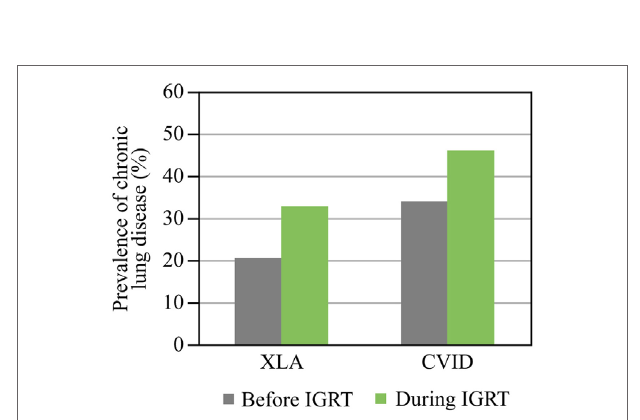
FigURe 3 | Prevalence of chronic lung disease before and during immunoglobulin replacement therapy (IGRT). Prevalence before and during IGRT is shown. Data for chronic lung disease are from Plebani et al. (XLA) (39) and Quinti et al. (CVID) (40). Abbreviations: CVID, common variable immunodeficiency; XLA, X-linked agammaglobulinemia.